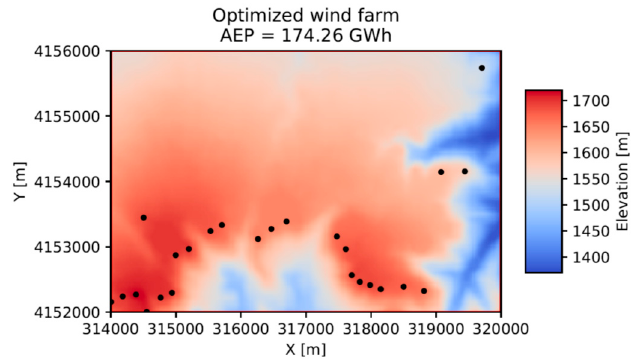
Figure 12. Best optimized design for the wind farm without any constraints (found by Random Search with (cid:1831) (cid:2923)(cid:2911)(cid:2934) = 10,000 and (cid:1839) (cid:2923)(cid:2911)(cid:2934) = 5000 m in the random